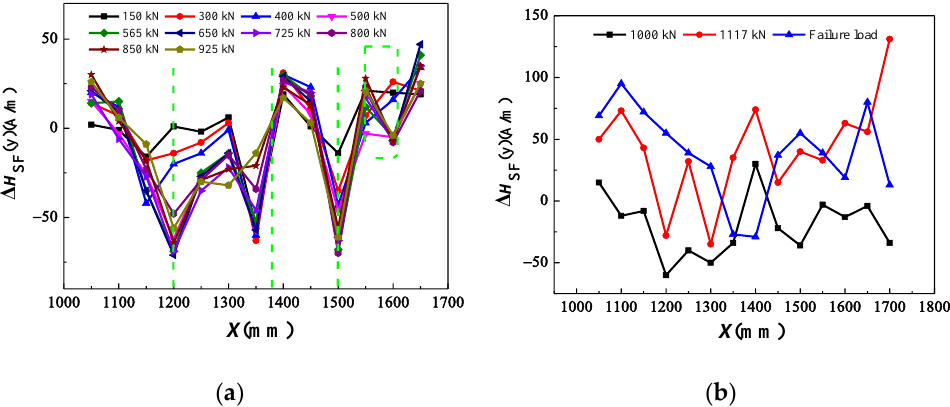
Figure 10. ∆𝐻 SF (y) curves of the top flange: ( a ) elastic and elastoplastic loading stages; ( b ) plastic deformation stage.